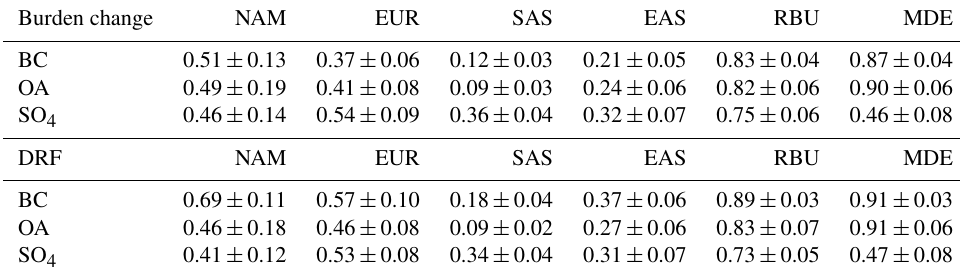
Table 4. Response to Extra-Regional Emission Reductions (RERER), averaged over the 10 participating models, ± 1 standard deviation representing inter-model spread. A high RERER value means that the given region is very sensitive to extra-regional emission reductions. The top table shows RERER for column aerosol burdens; the bottom table shows RERER for direct radiative forcing (DRF) calculated using vertically, spatially and temporally resolved AFE